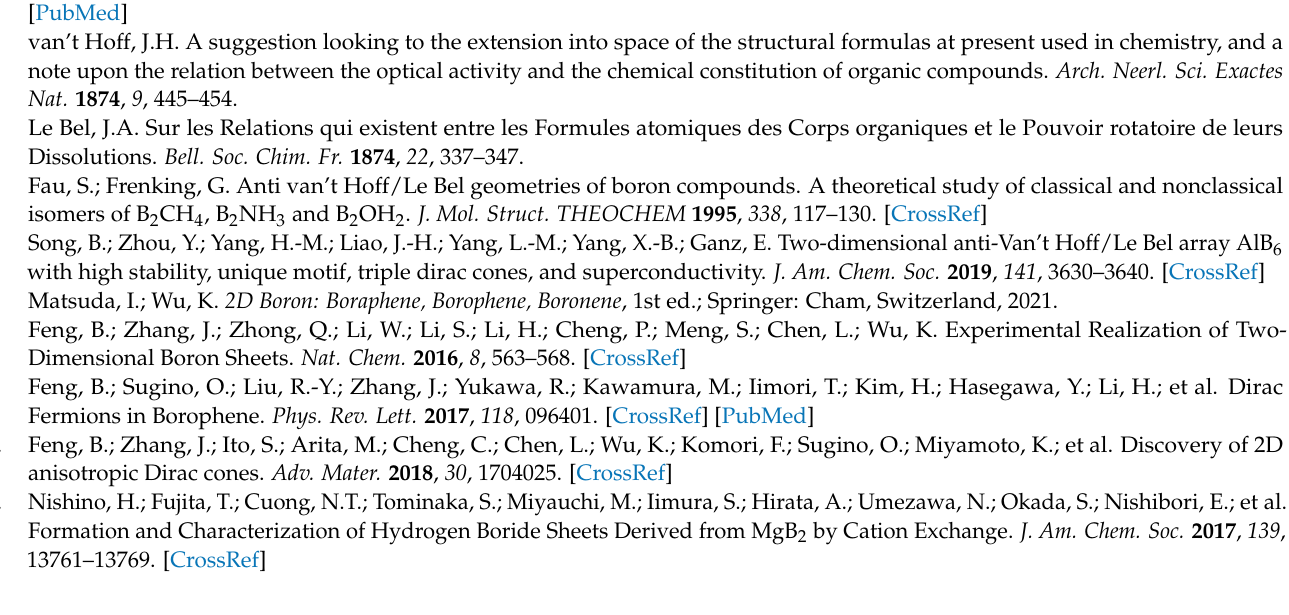
Figure A2d) arrangements of the 2:3:4:6:7:8:-H-1,5:1,5- µ H-B 8 H 8 molecule (Figure 4e,f). On an isolated molecule, the π bond is at a higher energy level than the σ bond. When the 2:3:4:6:7:8:-H-1,5:1,5- µ H-B 8 H 8 molecule is crystallized in 2D by forming intermolecular 3c- 2e B–H–B bonds, both molecular orbitals overlap with those on the neighboring molecules, and hopping integrals are introduced. Because of the out-of-plane structure of the 3c-2e bond, the sign of the hopping integral is different for the σ and π bonds, as discussed in reference [16]. The hopping integral for the π ( σ ) bond is negative (positive), so the band dispersion of the 2D crystal shows a cosine band with a lower (higher) energy at the Г point. These hopping integrals have energy scales comparable with those of the molecular orbitals, and thus the band is inverted at the Г point (Figure A2b). Because the inverted bands have different eigenvalues with respect to the mirror operation about the z = 0 plane, hybridization between them is prohibited and a gapless band crossing is produced, which is the DNL. The atomics structure of β 2 -borophane layer is shown in Figure A2e which has a different 3c-2e bonds arrangement from that of β 1 -borophane layer. The band structure of β 2 -borophane is shown in Figure A2f, which also has a DNL. The wave functions that form the lower (higher) bands of a DNL is π ( σ ) bonding states as shown in Figure 4g,h. The π bonding states of β 2 -borophane has nodes at 3c-2e bonds like that of β 1 -borophane, though the character of the wave function differs from the isolated 2:3:4:6:7:8:-H-1,5:1,5- µ H-B 8 H 8 molecule due to the different 3c-2e bonding arrangement. Figure A3 to evaluate their stability. The phonon dispersion of the β 1 -borophane shows the imaginary phonon, which implies that the β 1 -borophane layers are unstable. On the other hand, the β 2 -borophane shows that all the band dispersion is positive. Though the absence of imaginary phonon modes implies kinematic stability, but it may not be sufficient to conclude their actual existence because quadratic phonon bands appear near zero phonon